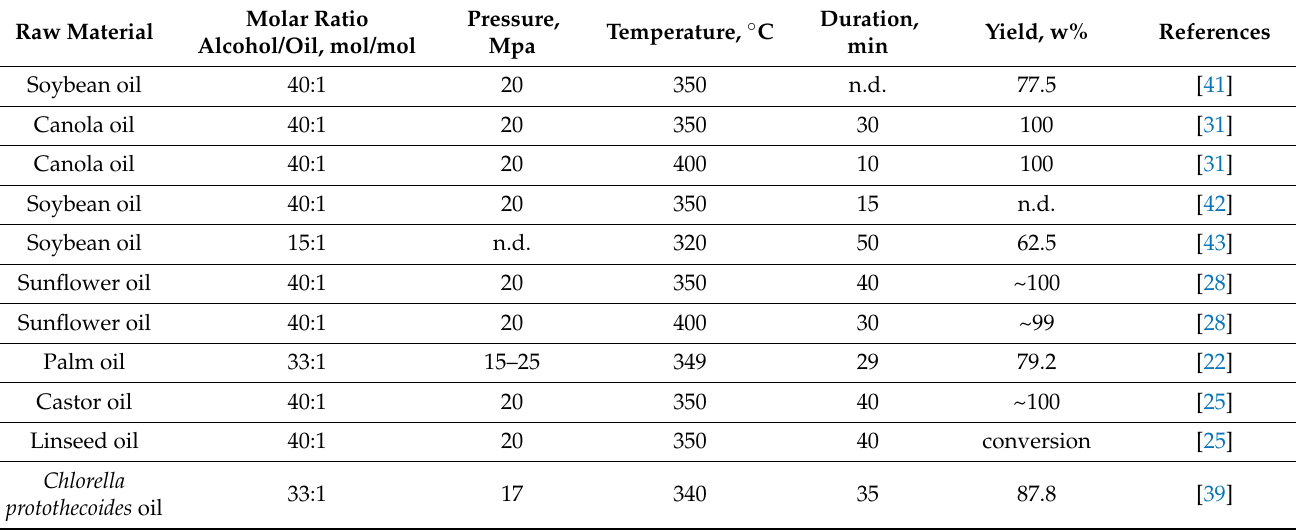
Table 2. Summary of reported experiment data of non-catalytic biodiesel production using supercritical ethanol. Molar Raw Material